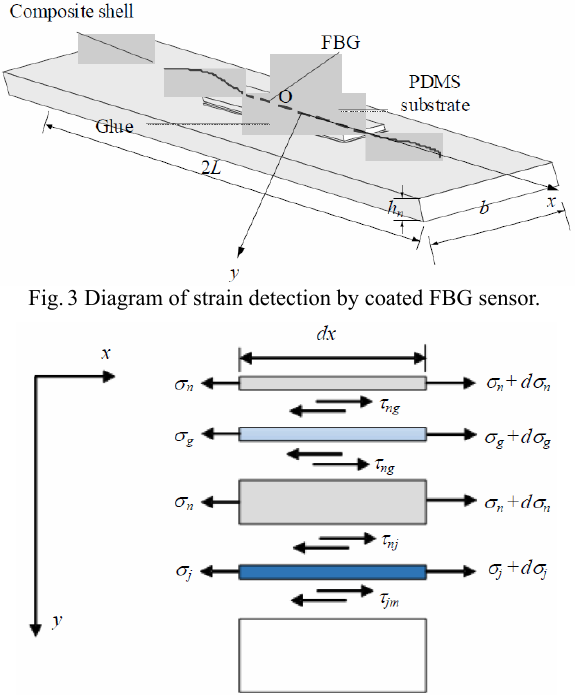
Fig. 4 Diagram of symmetrical section of the theoretical model loading